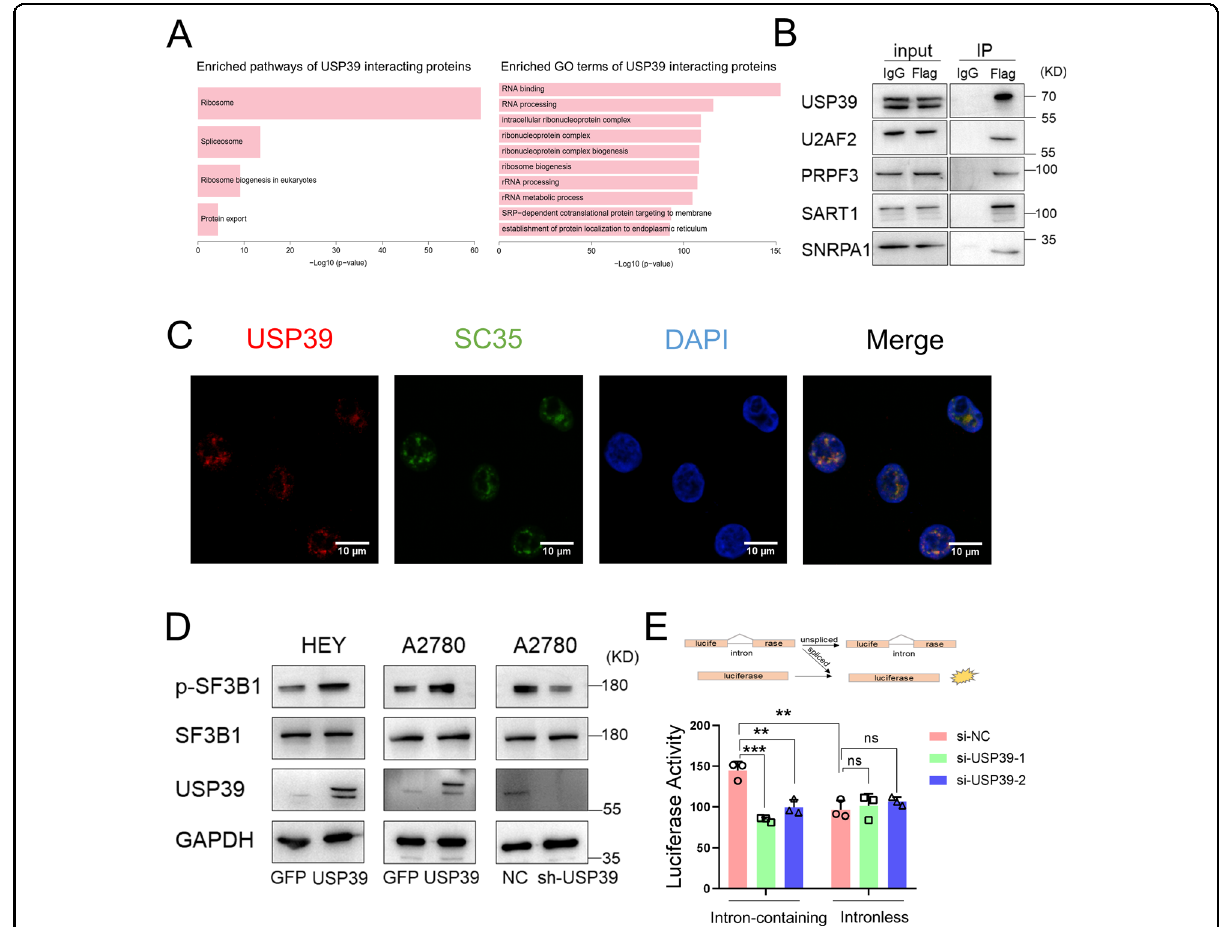
Fig. 5 USP39 interacts with several spliceosome components and colocalizes with SC35 in nuclear speckles. A KEGG pathway and GO enrichment analysis of proteins pulled down by FLAG antibody from A2780 cells expressing FLAG-tagged USP39. B Co-IP of U2AF2, PRPF3, SART1, and SNRPA1 from A2780 cells expressing FLAG-tagged USP39 was detected by western blot. IgG was used as a negative control. C Immuno fl uorescence experiments revealed colocalization of USP39 (red) and splicing factor SC35 (green) in punctate nuclear speckles. D Western blot analysis of phospho-SF3B1(Thr313) and non-phosphorylated SF3B1 in HEY and A2780 cells with USP39 overexpression (HA-USP39) and control (HA-GFP) and A2780 cells with USP39 knock-down (sh-USP39) and control (pGIPZ-NC). E A splicing reporter assay was performed to assess the ef fi ciency of splicing regulated by USP39. Inhibition of USP39 by small interfering RNAs (si-USP39-1 and si-USP39-2) signi fi cantly reduced the luciferase activity of an enzyme encoded by an intron-containing gene but had little effect on that encoded by an intronless gene ( n = 3 biologically independent samples). P value was obtained by Student ’ s t -test. Results represent the mean ± SD of three independent experiments. * P < 0.05, ** P < 0.01, *** P <